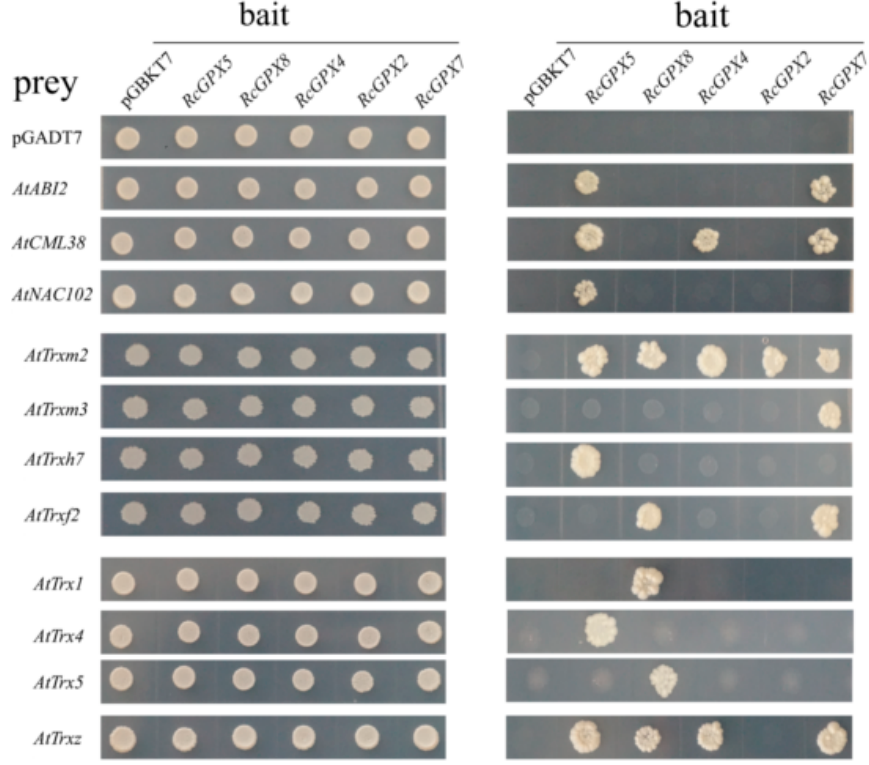
Figure 8. The putative interaction proteins of RcGPXs were investigated by yeast two—hybrid assays. Y2H gold yeast strains containing RcGPXs as bait and Arabidopsis genes as prey were grown on SD solid media lacking Trp and Leu for 5 days ( left panel ) and were assayed for reporter gene His expression by growing on SD solid media lacking Trp, Leu, and His ( right panel ). Prey and bait empty vectors were used as negative control. The Arabidopsis genes: AtABI2 (AT5G57050.1); AtCML38 (AT1G76650); AtNAC102 (AT5G63790); AtTrxm2 (AT4G03520.1); AtTrxm3 (AT2G15570.2); AtTrxh7 (AT1G59730.1); AtTrxf2 (AT5G16400.1); AtTrx1 (AT1G76760); AtTrx4 (AT1G19730.1); AtTrx5 (AT1G45145.1); and AtTrxz (AT3G06730.1). Thioredoxin (Trx) gene family encoding of the low weight molecules which has been confirmed model for GPXs and Trx have been calculated [19,47]. So, sixteen thioredoxin genes of Arabidopsis thaliana belonged to three subfamilies including y, m, and f type were chosen to investigate the protein’s relationship with RcGPXs . As the result showed, only half of AtTrxs genes presented